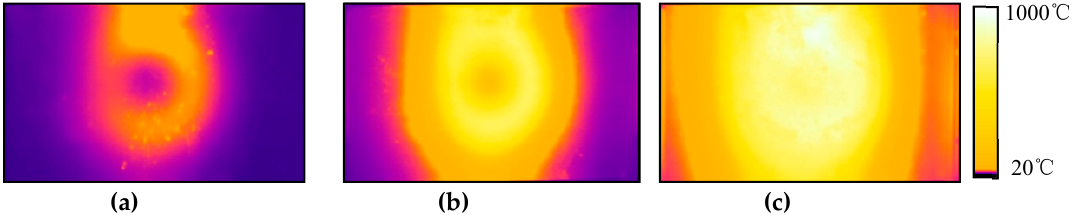
(b) Figure 4. Temperature distribution of sheet after selective heating . ( a ) Top view: the red rectangle is the axial temperature measurement area. This area is taken as a microstructure characterization sample; ( b ) central axis: temperature is measured along horizontal axis. 3. Characterization of Hot-Stamping Parts with Tailored Properties Hardness testing and metallographic testing were conducted to assess the microstructure distribution and load-bearing performance, respectively. This was performed by cutting a beam 90 mm long and 3 mm wide symmetrically along the horizontal axis. The sampling location is shown in the red area of Figure 4a. The hardness was measured every 0.2 mm along the axis by a microhardness tester. In Figure 5, Vickers hardness values are plotted on a length scale, where the bar mid-length is taken as the origin. The results show that the hardness is high in the middle of the specimen and the value of the high-strength zone is from 440 HV to 550 HV, and the length is from − 21.66 to 27.89 mm, which is consistent with the heating range of the high-temperature zone. The high-temperature zone is fully austenitized in preheating and martensitic transformation occurs after quenching. The hardness fluctuation corresponds to the winding of the induction coil, which indicates that the faster the heating speed, the higher the hardness of the martensite. The ranges of the hardness value decrease rapidly in the transition zone, located from 3.73 mm on the left and 2.61 mm on the right, which has a graded multiphase microstructure. Away from the hot zone, the hardness of the low- hardness zone at both sides is 178–230 HV, and the hardness of the initial phase after heating is slightly higher than before. According to the hardness distribution, the sample shows a gradual structure gradient, which can be divided into three zones: the hard zone, the transition zone and the soft zone. The microstructure of each zone, observed by optical microscopy, is shown in Figure 6. The soft zone is the initial phase, with about 200 HV, which is the mixed structure of ferrite and pearlite. According to the calculation of the intercept method, the grain size is about 10